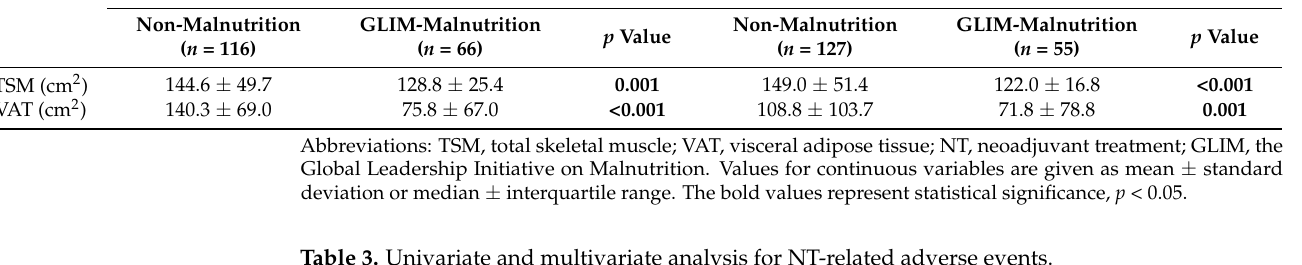
Table 3. Univariate and multivariate analysis for NT-related adverse events.